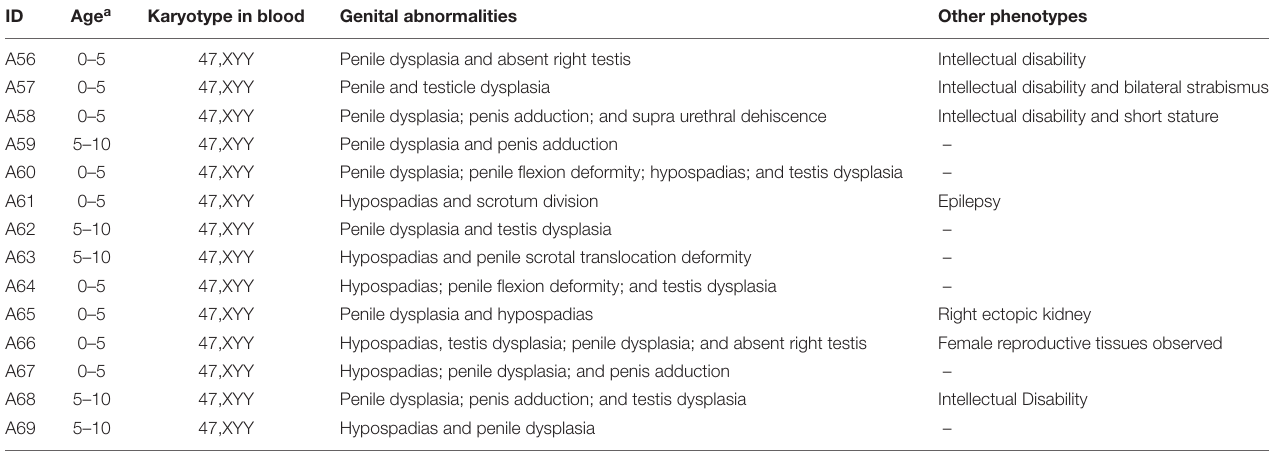
TABLE 1 | Clinic information for 14 DSD males with XYY in blood, which observed from 4,437 DSD